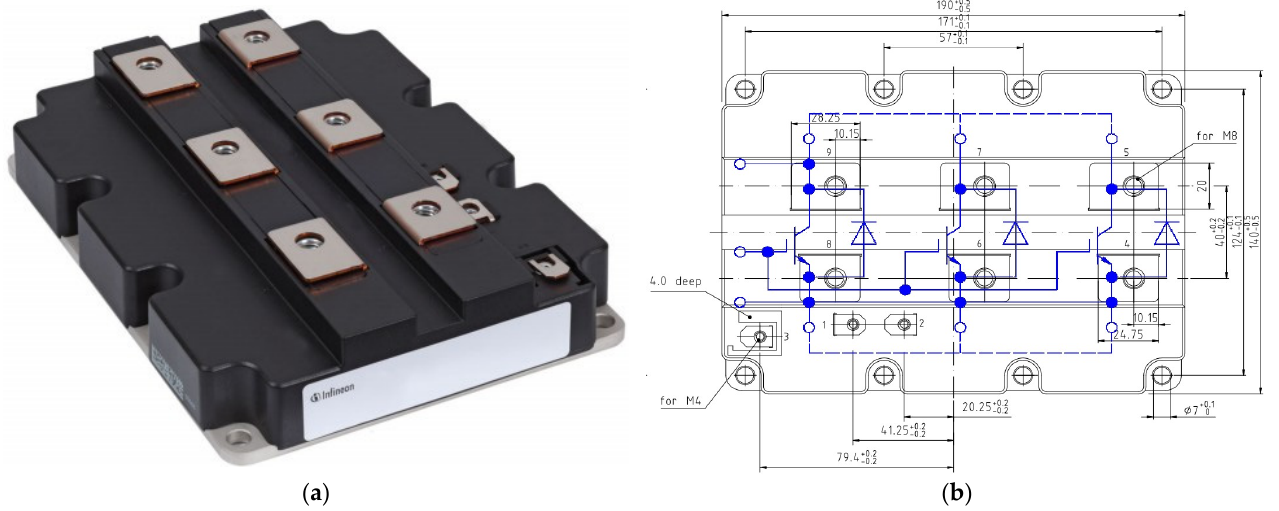
Figure 4. ( a ) Outline and ( b ) inward of IGBT module FZ1500R33HE3 targeted by the experiments.